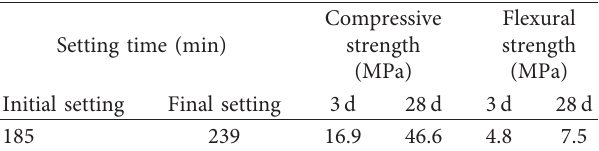
Table 1: Physical properties of the PO 42.5 ordinary Portland